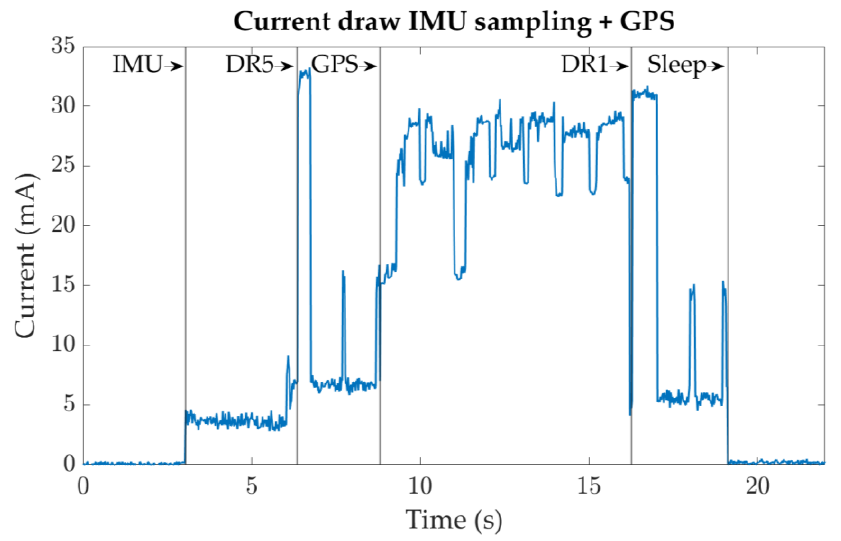
Figure 7. Current consumption while sampling IMU at 12.5 Hz and activating GNSS receiver.